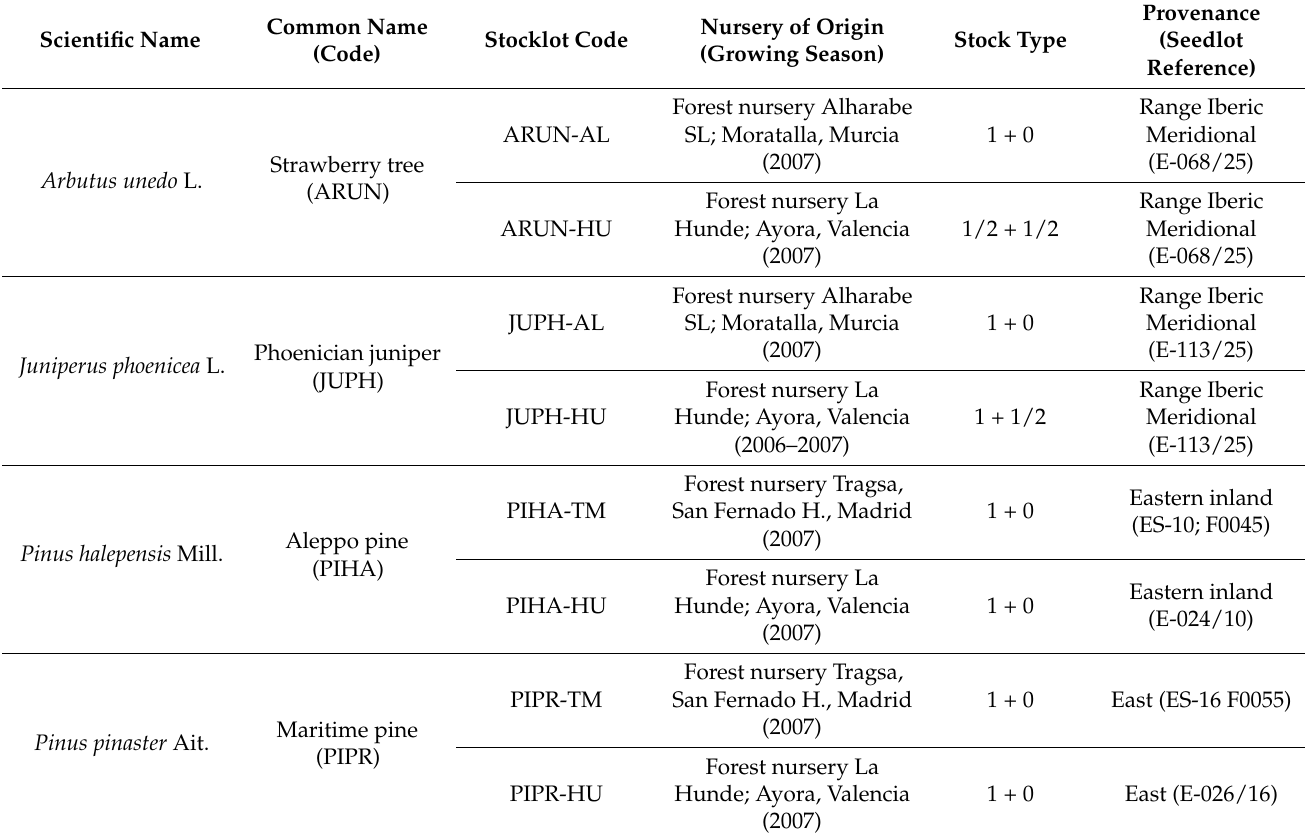
Table 1. Species and stocklots’ distribution in the experimental